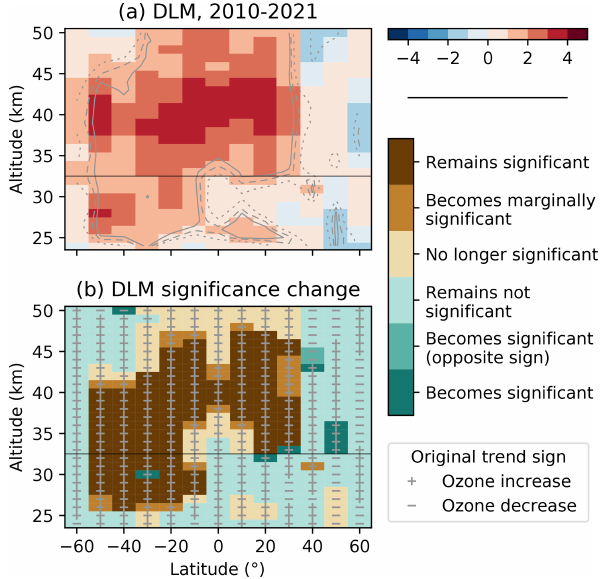
Figure 5. (a) As in Fig. 2b, for 2010–2021, in the upper and mid- dle stratosphere only. The color scale limits are halved, given the shorter period. (b) As in Fig. 4, for 2010–2021. An additional green shade indicates trends that become significant and change sign com- pared to the original (insignificant)